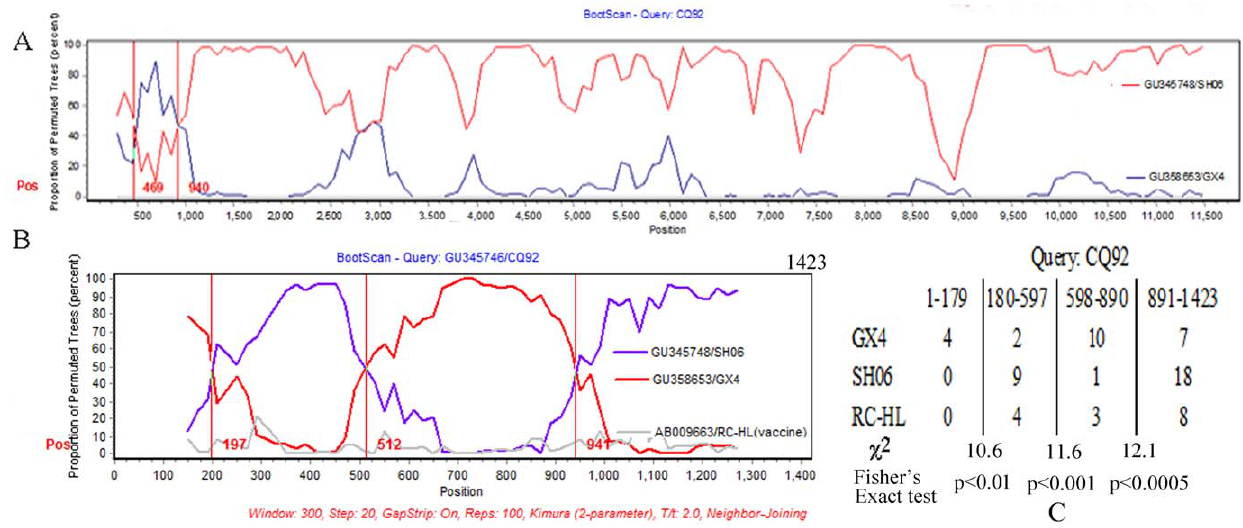
Figure 3. Analysis of recombination breakpoints. (A) The bootscan result of CQ92, GX4 and SH06 complete genome. RC-HL was used as the outgroup. The window size was set at 600 bp to avoid noise from gene mutations. (B) The bootscan result of region from positions 1–1423. The parameters used for analysis are shown on the bottom row of the figure. The window size was set at 300 bp. The three crossover sites are represented by vertical lines. (C) The statistical analysis of informative sites. Vertical lines represent the recombination breakpoints with the maximization of x 2 . x 2 of each breakpoint and P -value of Fisher’s exact test are shown under the vertical lines.